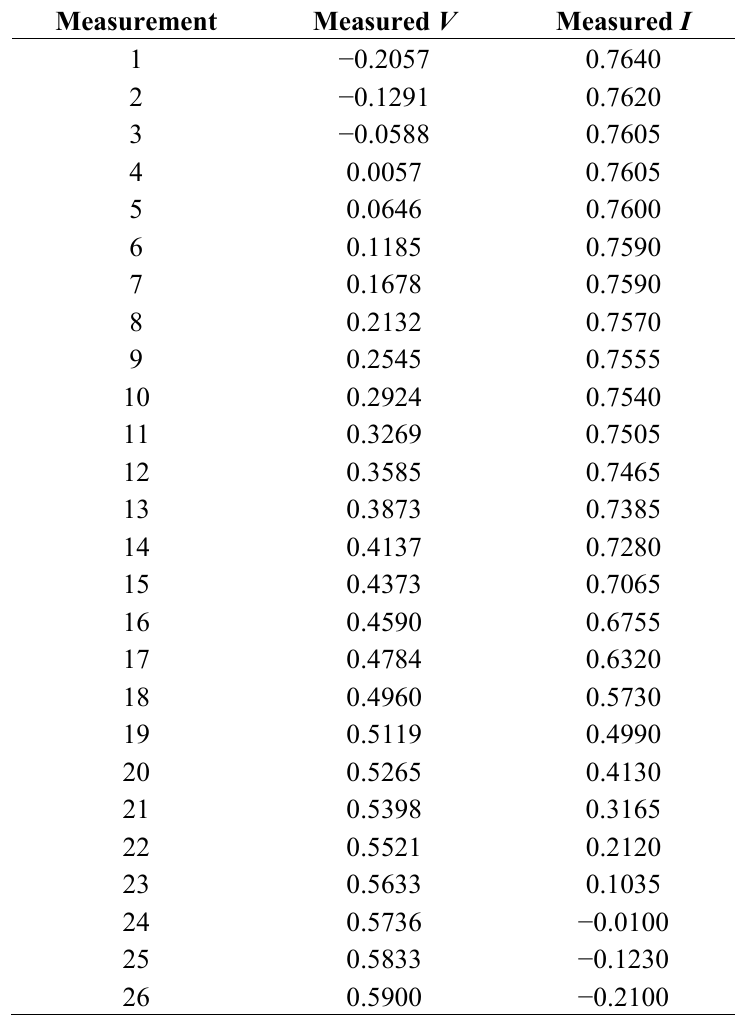
Table 4. Terminal I - V measurements.